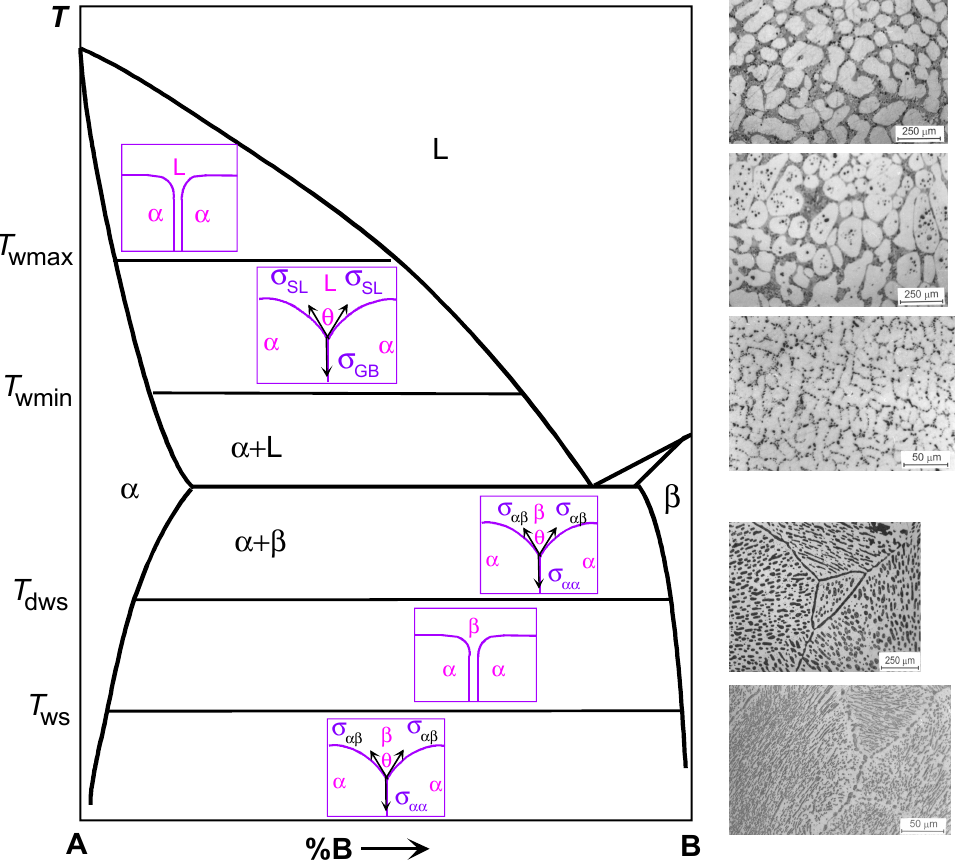
Figure 1. Schematic binary phase diagram for components A and B illustrating the GB wetting phenomena. Bold solid lines show the bulk phase transformation. Thin solid lines show the tie-lines for the GB wetting by the melt at T wmin) and T wmax as well as by the second solid phase at T ws and T dws . Schemes between solidus and liquidus lines show the cases of complete (top) and partial (bottom) GB wetting by the liquid phase ( L ). Schemes between solvus lines for α - and β -phases show the cases of complete (middle) and partial (top and bottom) wetting of the α / α GB by the second solid phase β . Micrographs on the right-hand side of the diagram (above the dotted line) show the microstructure for the Al–Mg samples annealed above T wmax (top micrograph, all GBs are completely wetted), between T wmin and T wmax (middle micrograph, some GBs are completely wetted and other GBs are partially wetted) and below T wmin (bottom micrograph, no completely wetted GBs). Micrographs on the right-hand side of the diagram (above the dotted line) show the microstructure for the Al–Zn samples annealed above T ws (top micrograph, all Zn/Zn GBs are completely wetted by the solid (Al) phase) and annealed below T ws (bottom micrograph, all Zn/Zn GBs are partially wetted by the solid (Al) phase). Micrographs for Al–Zn alloys are reprinted with permission from Ref. [61]. Copyright 2004 Elsevier. On the right hand side of the top of Figure 1, the microstructures of such two-phase binary Al–Mg polycrystals are shown as an example. As a result, two GB wetting border tie-lines appear in the phase diagram. The first line at T wmin is for the transition